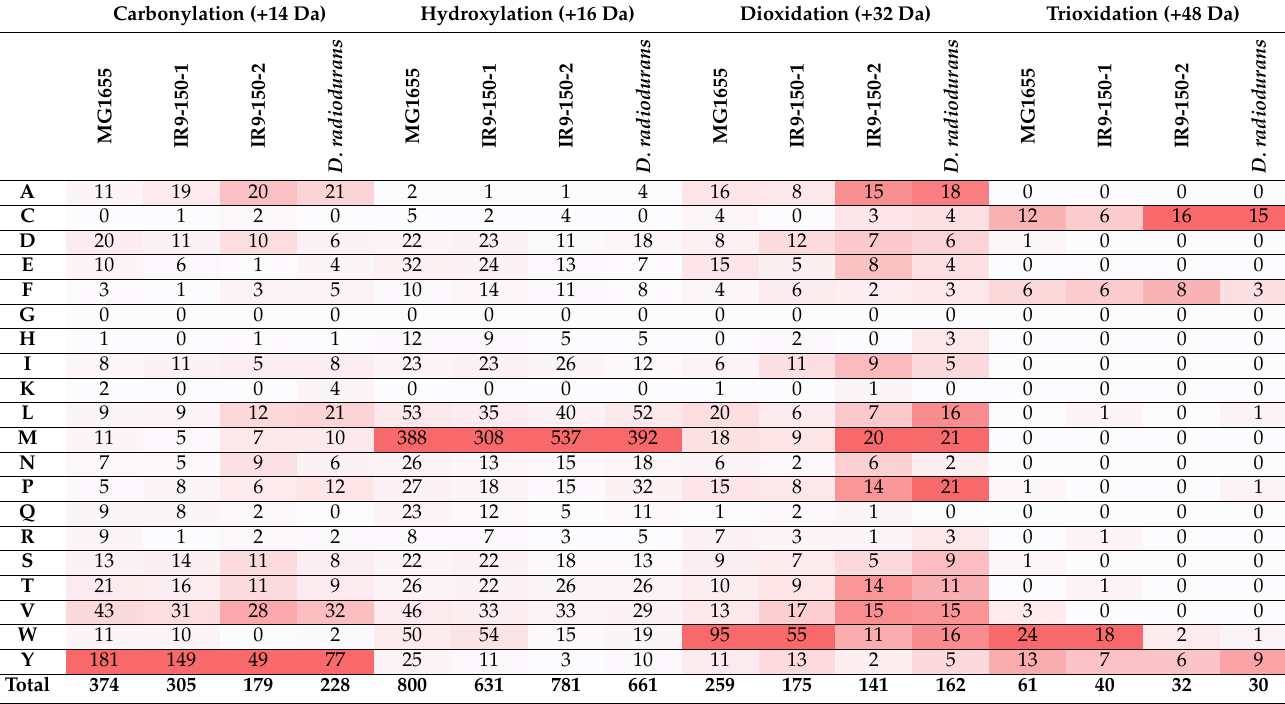
Table 5. Amino acid modifications on peptides exhibiting no change in